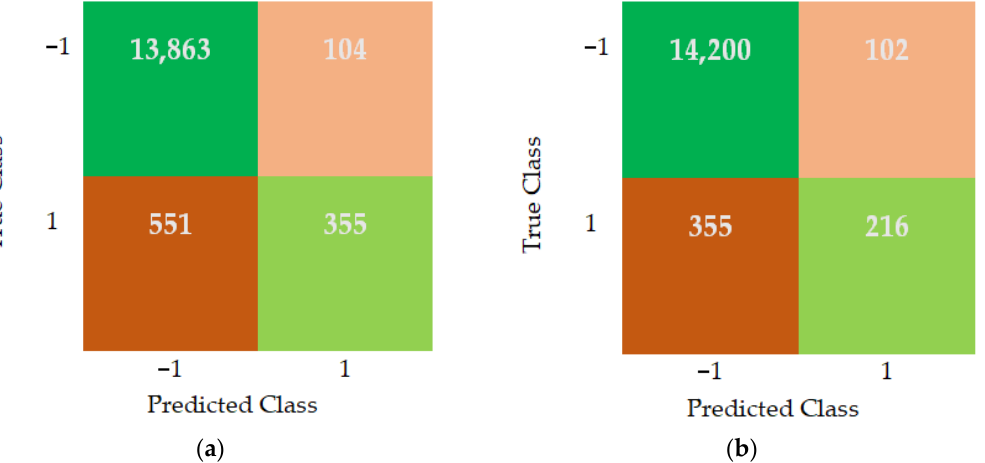
Figure 6. ( a ) The percentages of successfully and unsuccessfully learned points for both classes (Year 2019). ( b ) The percentages of successfully and unsuccessfully learned points for both classes (Year 2020).